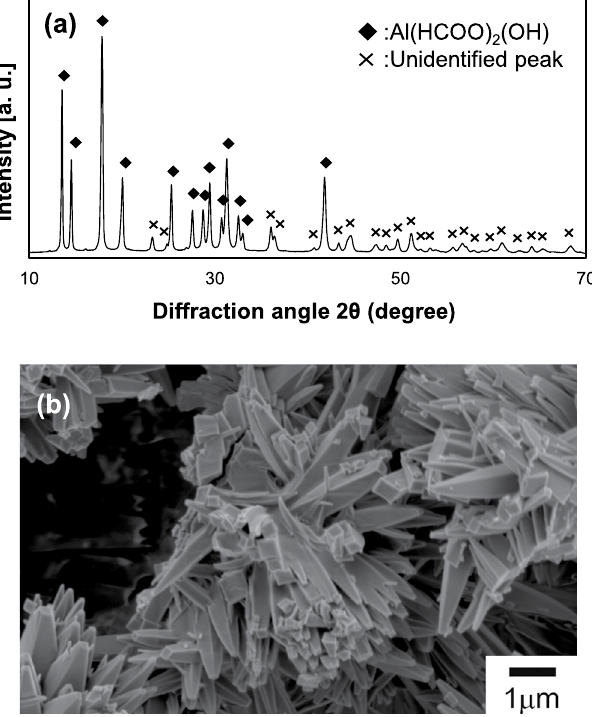
Figure 1. ( a ) XRD pattern using CuK α radiation and ( b ) SEM micrograph of the precursor